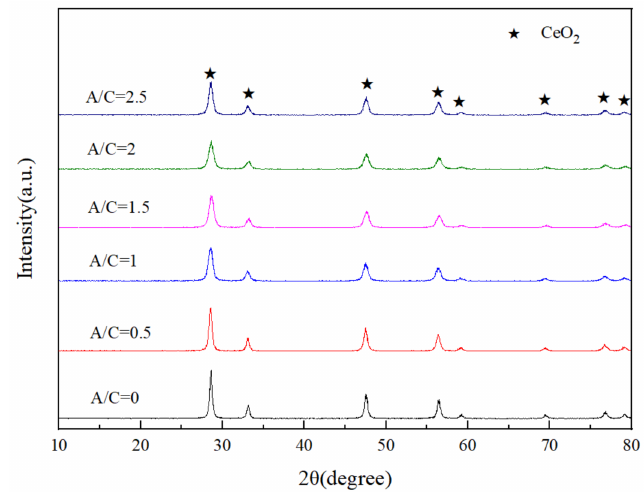
Figure 8. XRD patterns of the CeO 2 products prepared with various